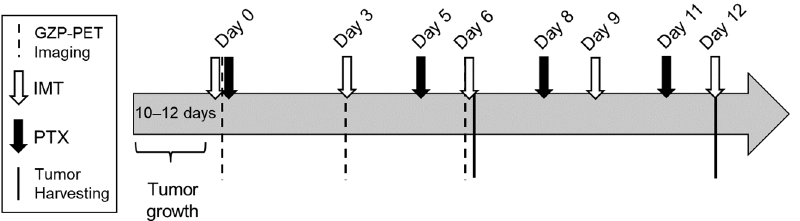
Figure 1. Experimental timeline. Abbreviations: Granzyme B specific positron emission tomography (GZP-PET), immunotherapy (IMT), paclitaxel (GZP-PET), immunotherapy (IMT), paclitaxel (PTX).